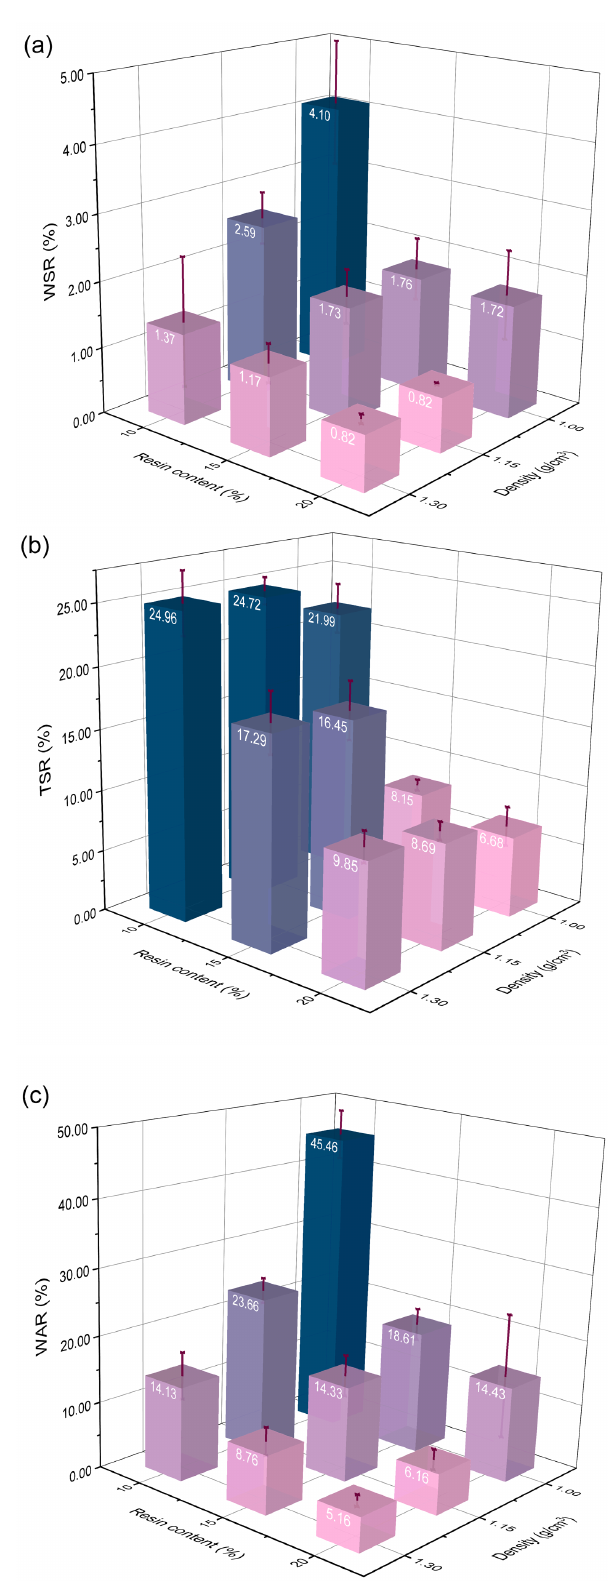
Figure 2. Water resistance of BSC samples including ( a ) WSR, ( b ) TSR, and ( c ) WAR.